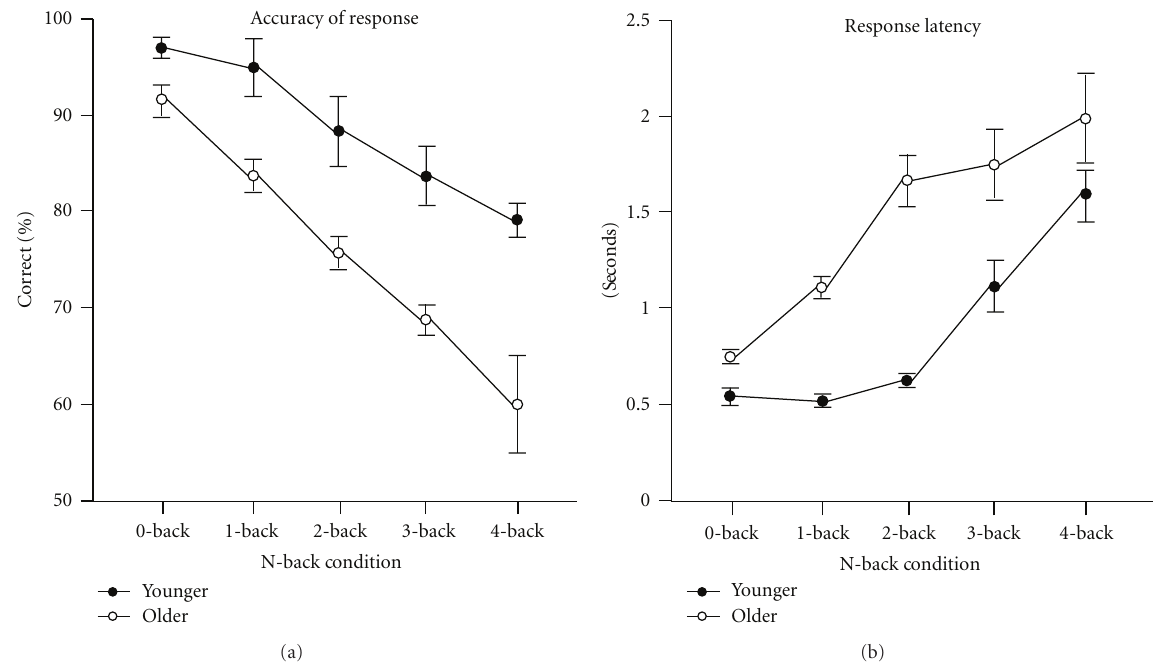
Figure 2: Accuracy (a) and latency (b) for older (open circles) and younger (closed circles) adults collected during fMR data acquisition. Error bars represent 1 SEM.